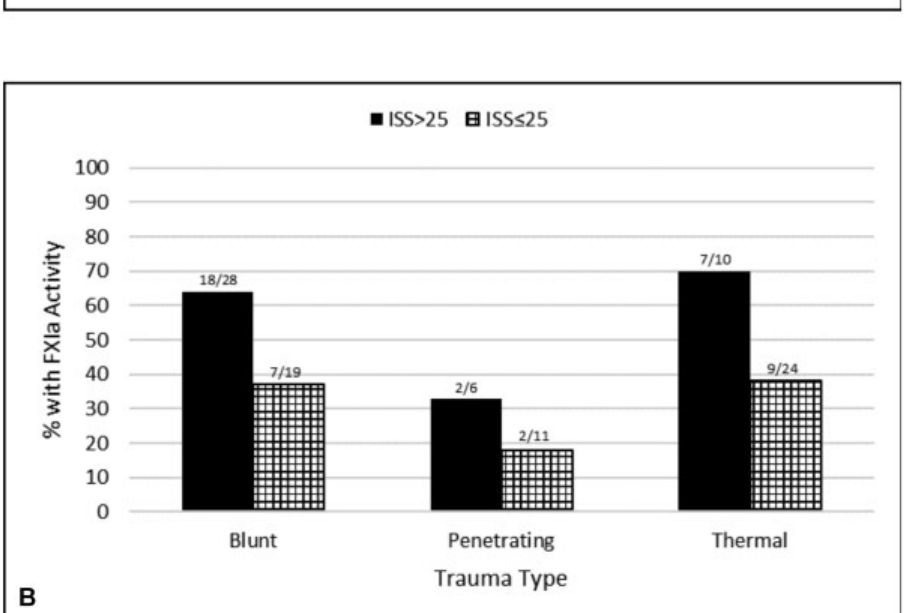
TH Open Vol. 3 No.